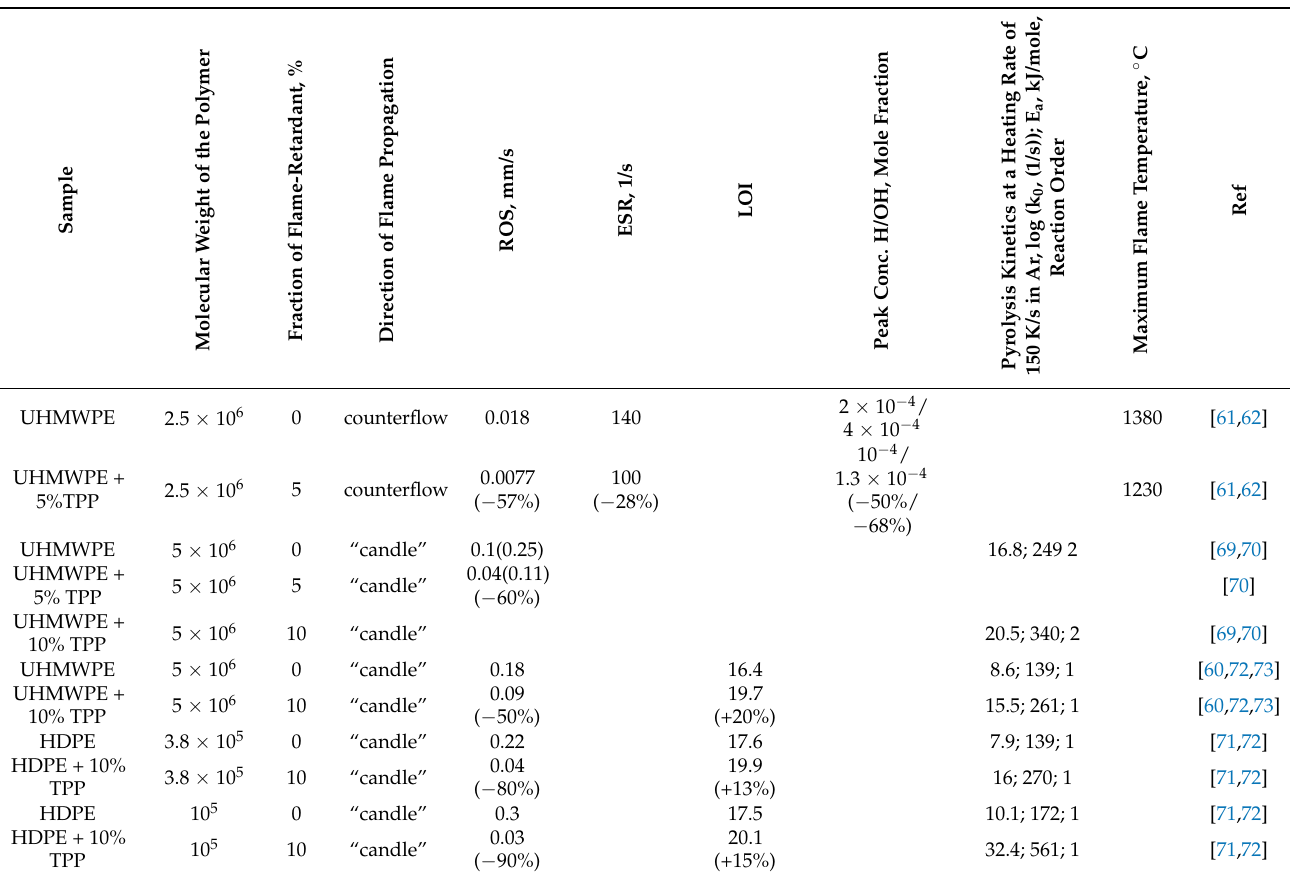
Table 3. Characteristics of combustion and thermal decomposition of polyethylene of various molecular weights without additives and with the addition of